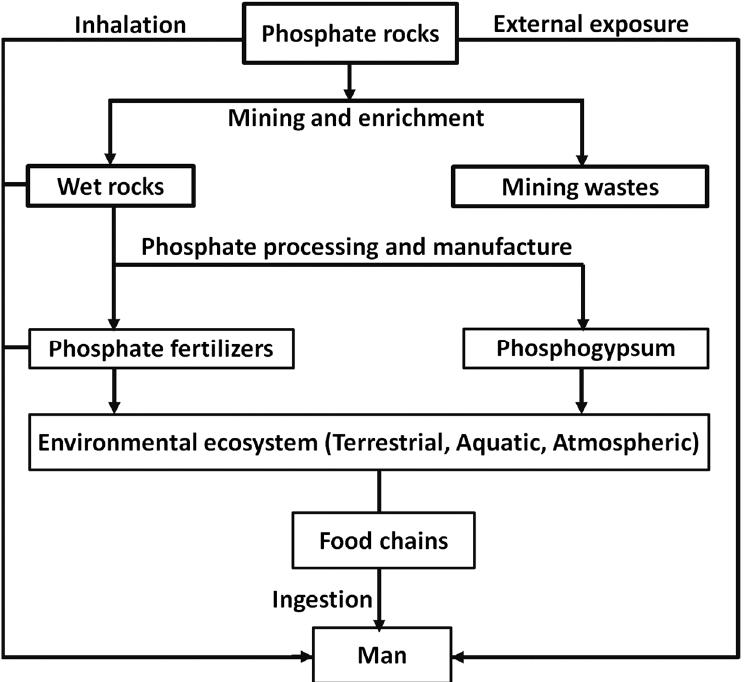
Figure 1. Environmental pathways of natural radionuclides from phosphatic rocks only (Modified from [25].